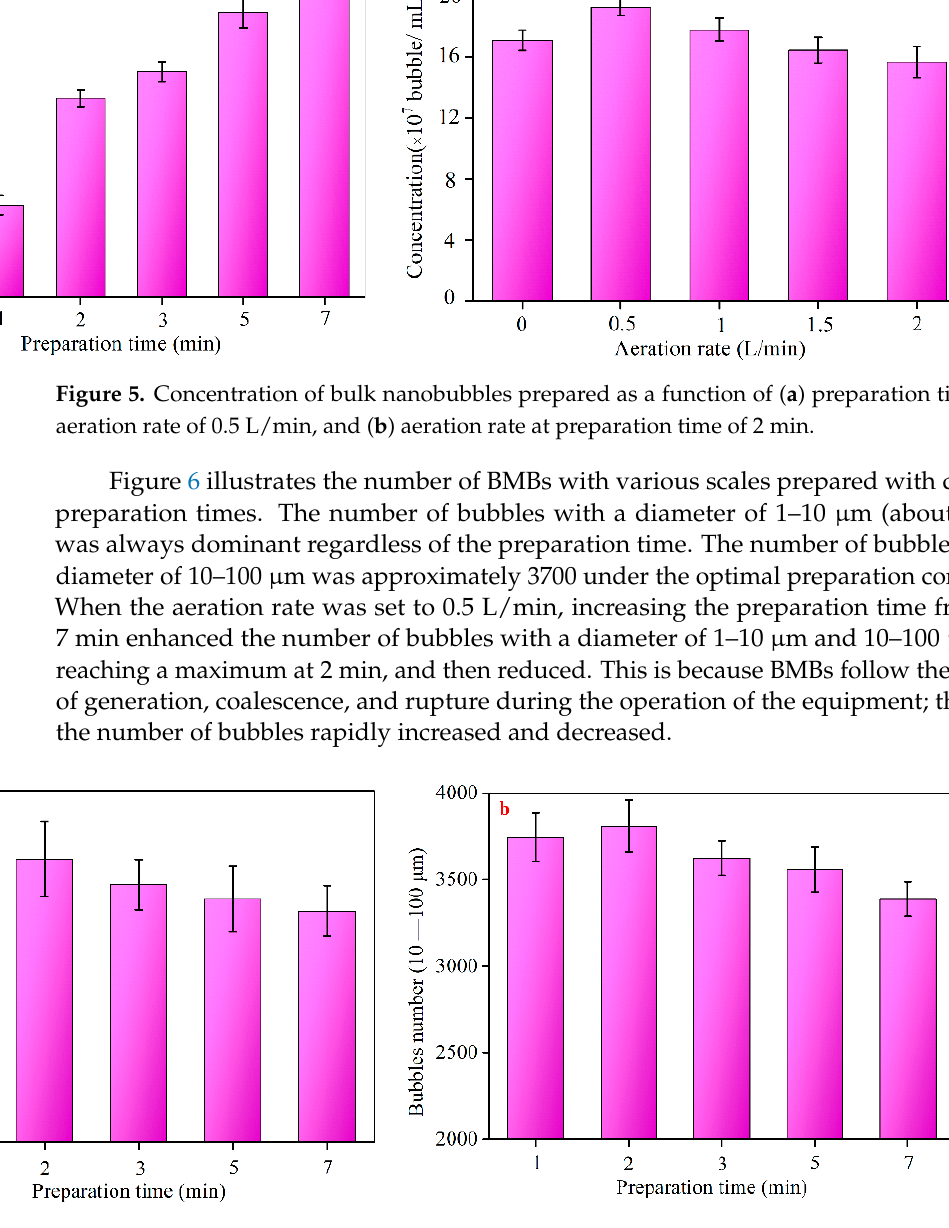
Figure 6. Number of bulk microbubbles prepared at different times: ( a ) 1–10 µ m, and ( b ) 10–100 µ m at aeration rate of 0.5 L/min.